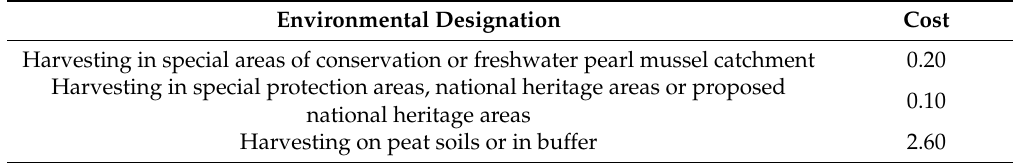
Table A5. Additional costs (in € m − 3 ) for harvest activities in specific areas. Source: Coillte.